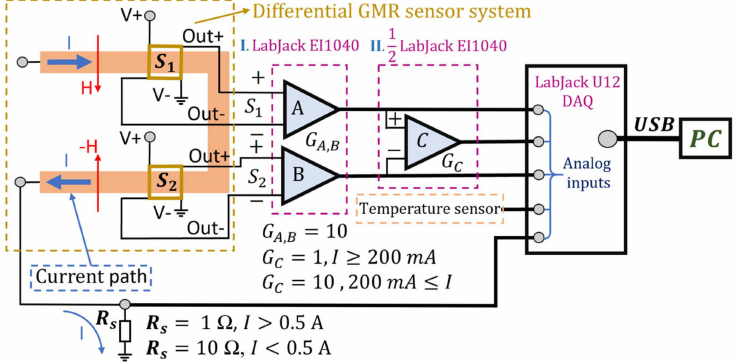
Figure 11. Current measurement di ff erential system using GMR sensors: functional block